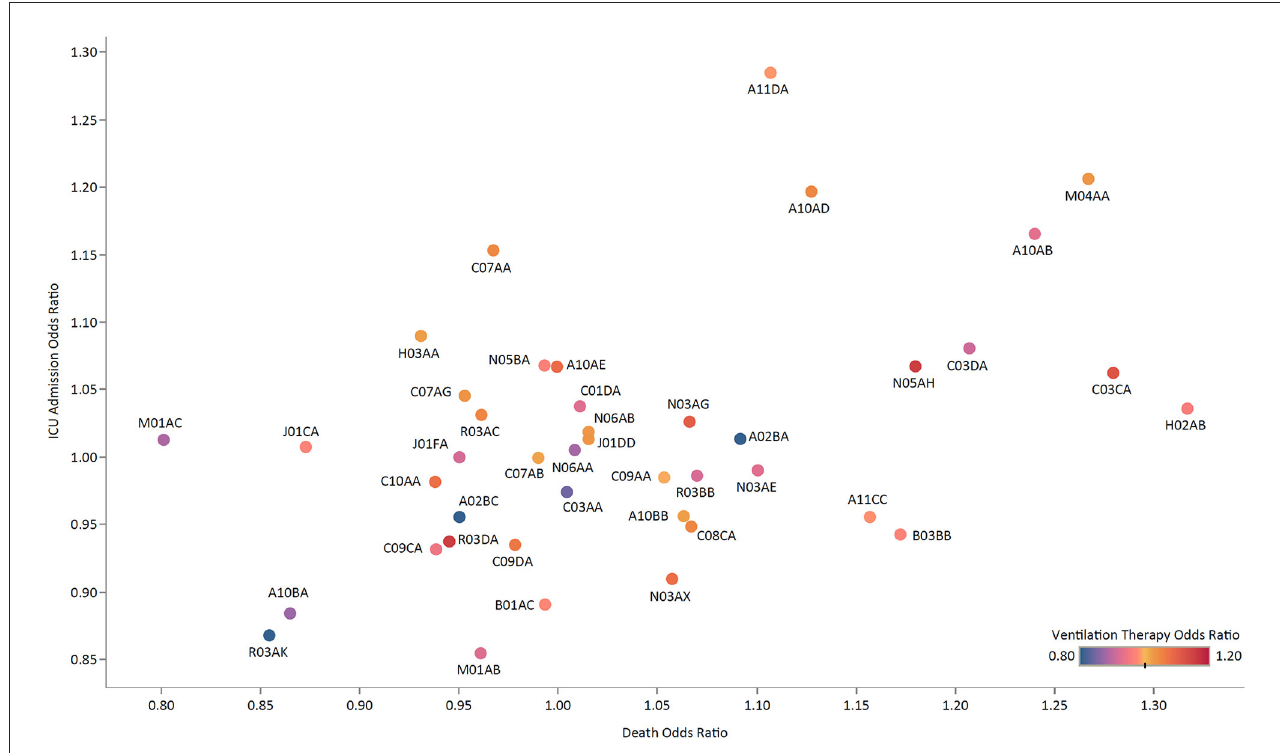
FIGURE3 The ORs of ICU admission vs. death for medication groups, colored by the OR of ventilation